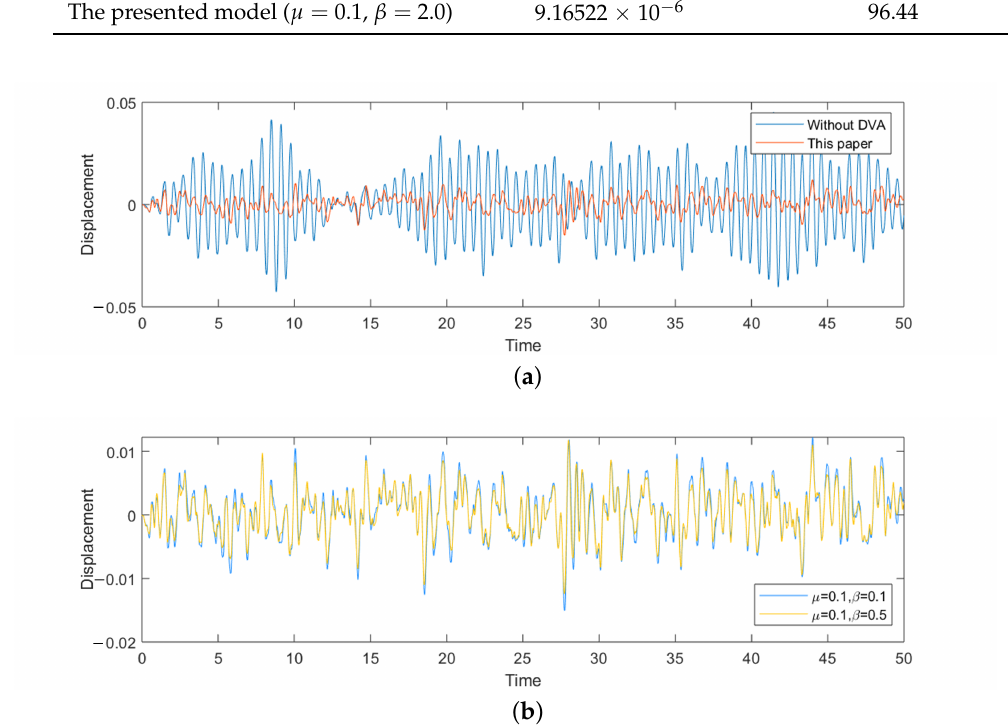
Figure 15. The time history of the primary system with models when µ = 0.1: ( a ) comparison of this paper and without DVA; ( b ) comparison between different inerter-to-mass ratios ( β = 0.1 and β =